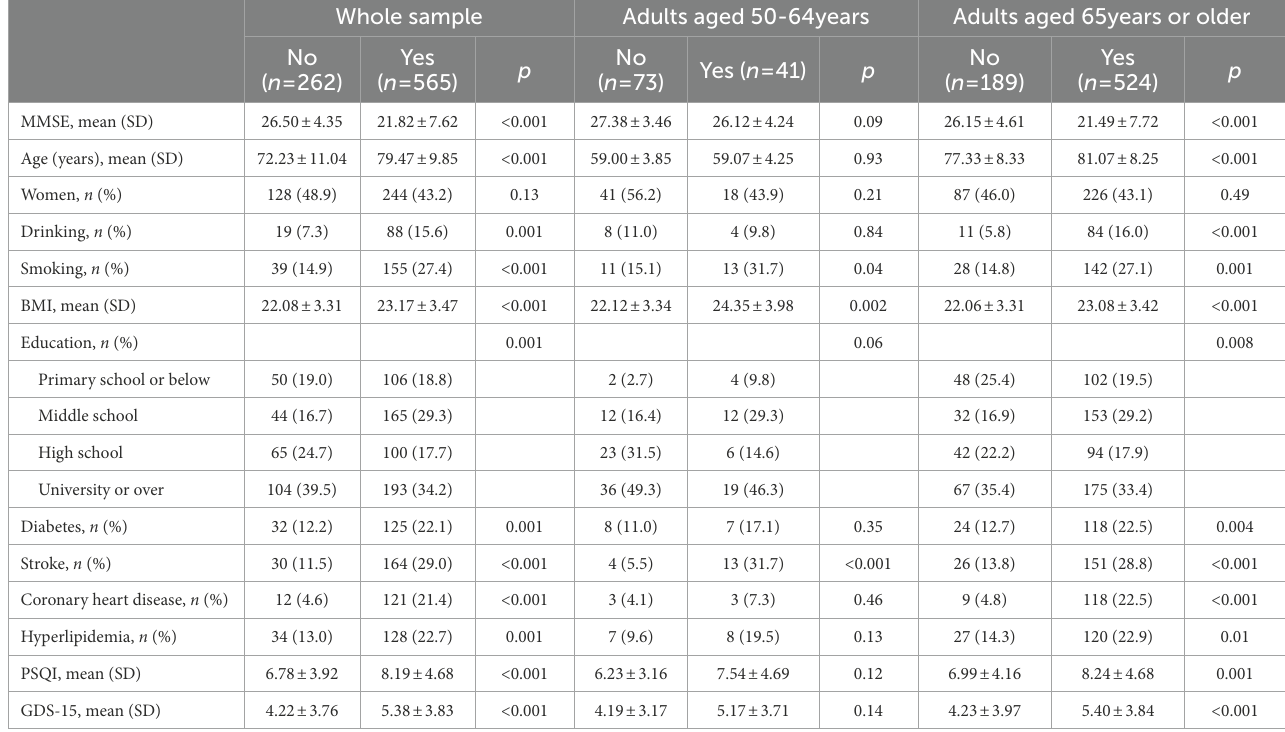
TABLE 1 Participant characteristics according to hypertension and stratified by age